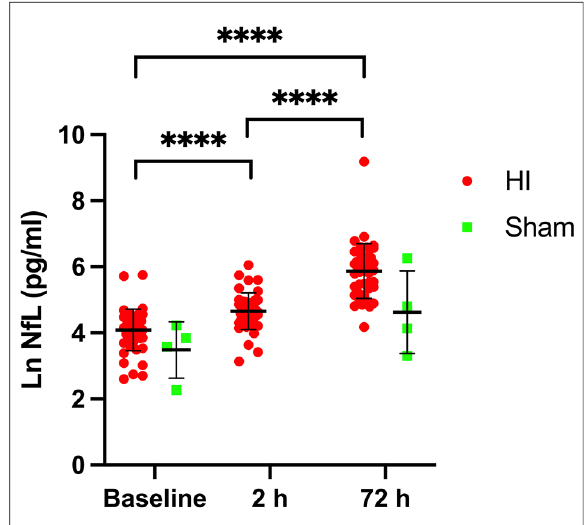
FIGURE 1 N fl serum levels at baseline/pre-HI, 2 h after HI and 72 h after HI (red circles) and in sham animals (green squares). **** p <0.0001, repeated measures ANOVA/mixed effects model with tukey test correction for multiple comparisons. Lines represent means and errorbars are standard